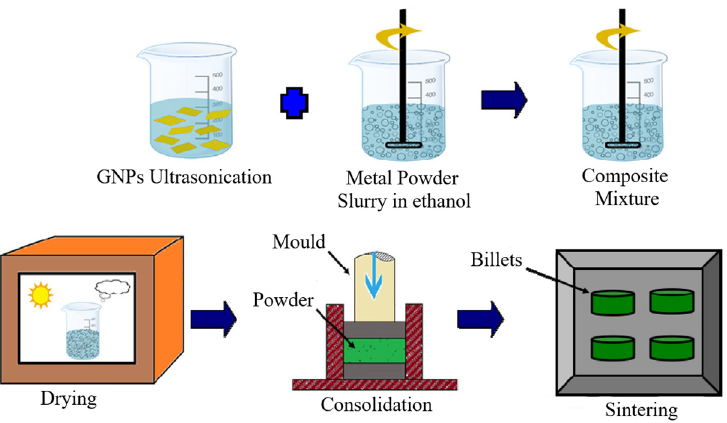
Figure 3. Flowchart of the semi-powder method.